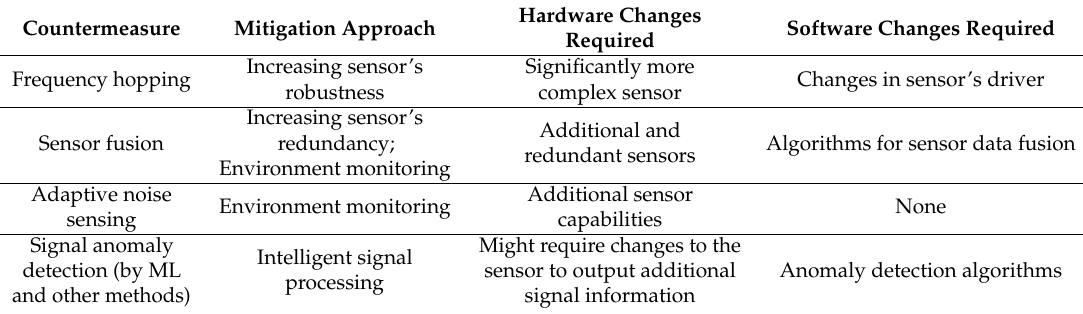
Table 3. Proposed countermeasures, along with the hardware and software changes required for